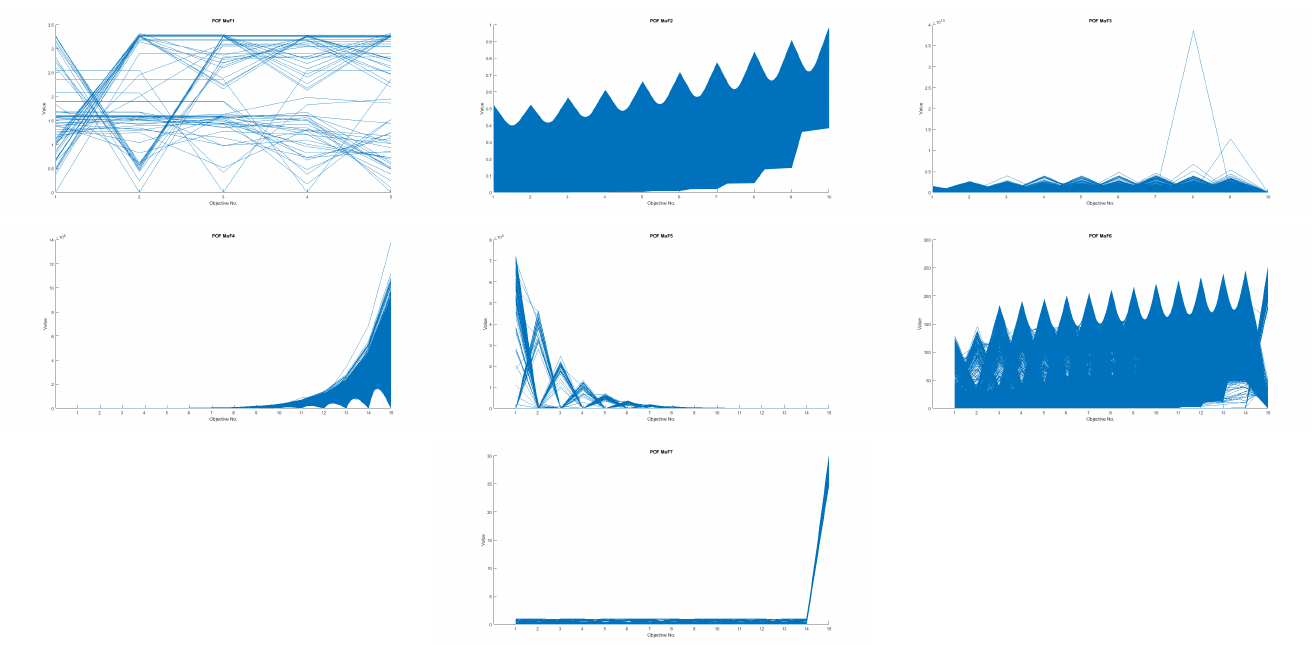
Figure 12. The plots of POF for MaF1-7 functions with 7 objectives using the DB-CSA algorithm. As a global conclusion and based on comparative studies (1) and (2), all